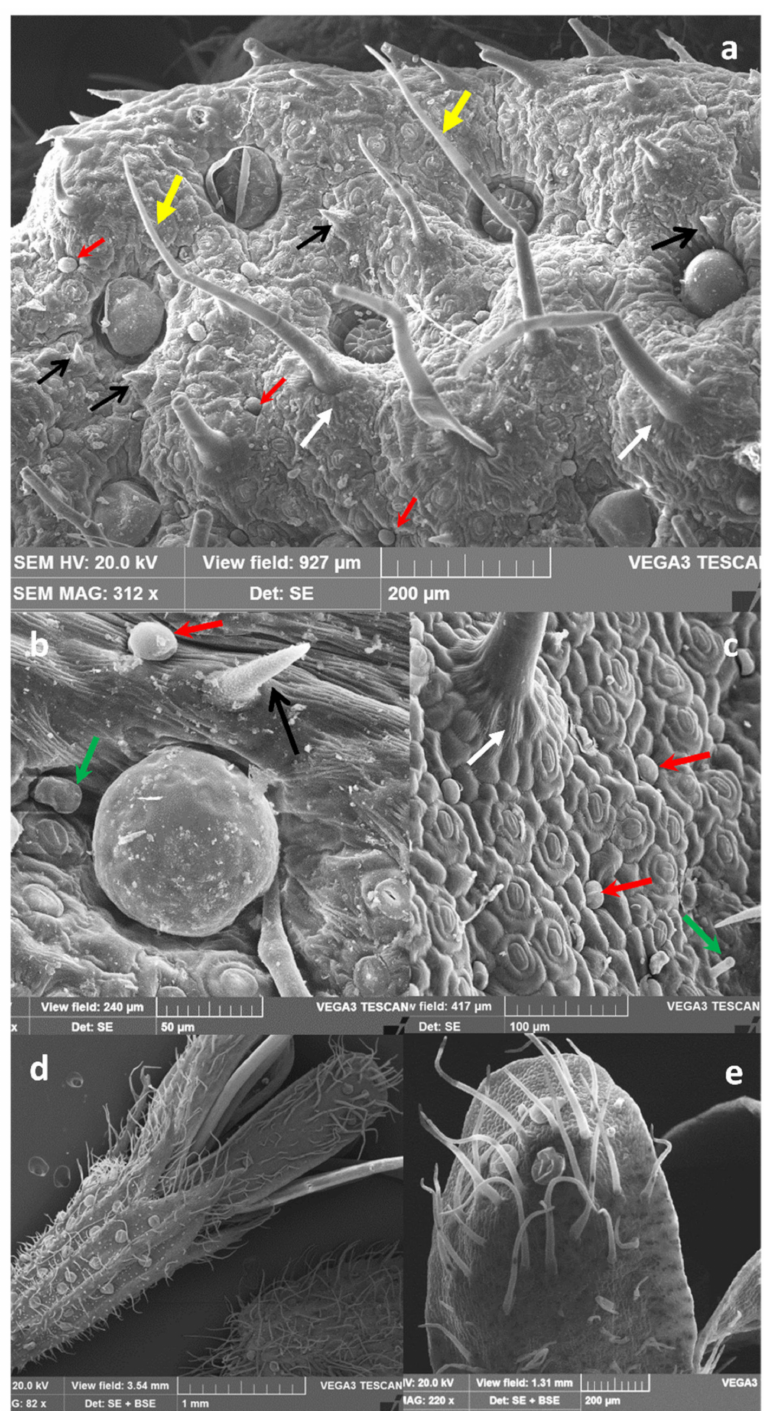
Figure 3. M. pulegium leaves ( a – c ) and flowers ( d , e ). Non-glandular trichomes and glandular trichomes on the leaf surface of mature leaves are shown ( a – c ); ( a ), capitate type I trichomes are indicated by red arrows, and capitate type II ones by green arrows; black arrows indicate short unicellular trichomes, yellow arrows indicate long multicellular uniseriate trichomes, while around their base, epidermal cells arranged in a circle to form a pedestal are shown by white arrows. ( d ) Long multicellular, uniseriate non-glandular trichomes are visible on the calyx, together with many peltate trichomes arranged in rows between the ribs. ( e ) On the outer face of the petal apex, multicellular trichomes appear thin, long, and lean toward the apex, while only a very few peltate trichomes can be